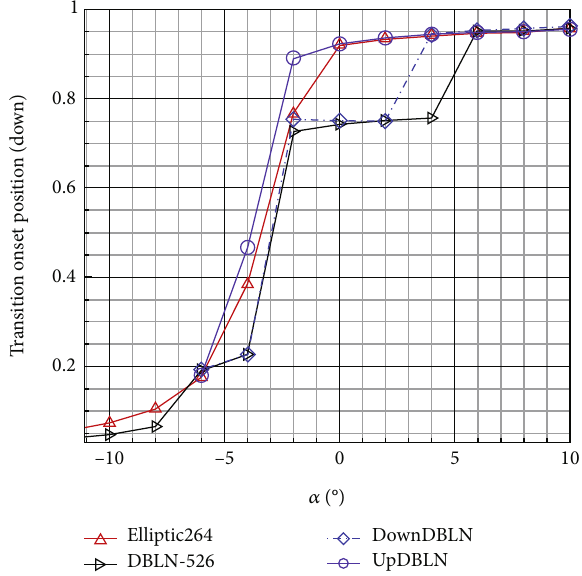
Figure 24: Transition onset position (lower surface).